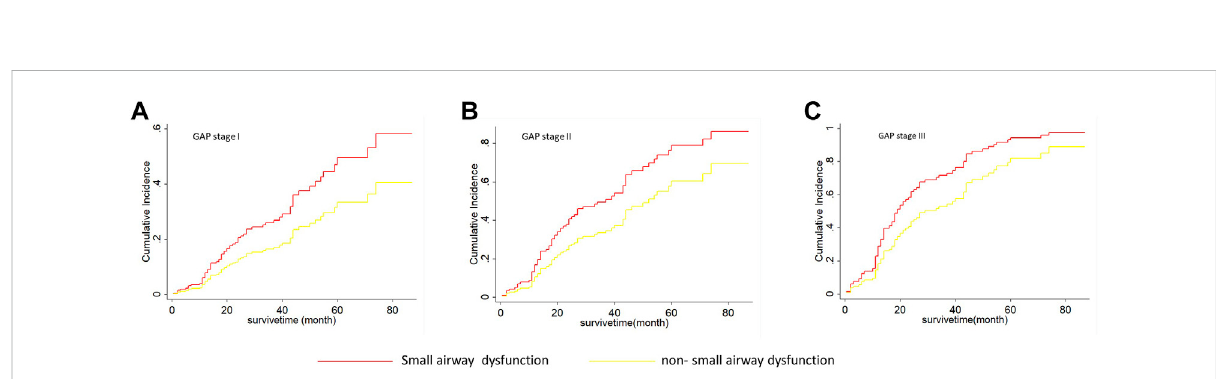
FIGURE 6 ThecumulativeriskofdeathwithSADandnon-SADindifferentGAPstagesbasedontheFine-Grayregressionmodel. (A) Cumulativedeathrisk curve of patients with SAD and non-SAD in GAP stage I; (B) Cumulative death risk curve of patients with SAD and non-SAD in GAP stage II; (C) CumulativedeathriskcurveofpatientswithSADandnon-SADinGAPstageIII;IPFcomorbidSADhadthehighdearthriskinallGAPstages.Note:The red curve indicates that PFT diagnoses SAD; the yellow curve indicates that PFT diagnoses non-SAD. GAP (gender, age, and physiologic variables) stage followed the recommendation by Brett Ley, and a higher stage represented a greater death